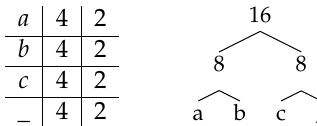
Figure 1. Illustrations for the instance based on the text T = “ba_bb_caca_ba_cc”, minimizing the number of occurrences of “EI” in its EI signature S ( T ) = “EEE EI II”. The columns of the array respectively list the messages, their numbers of occurrences and the code lengths assigned to